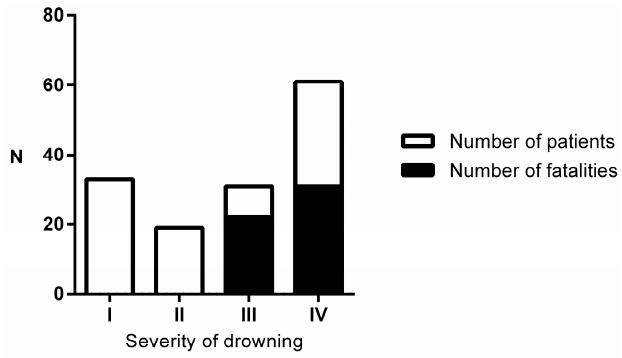
Figure 1. Distribution of fatalities in relation to the severity of drowning (N = 144).